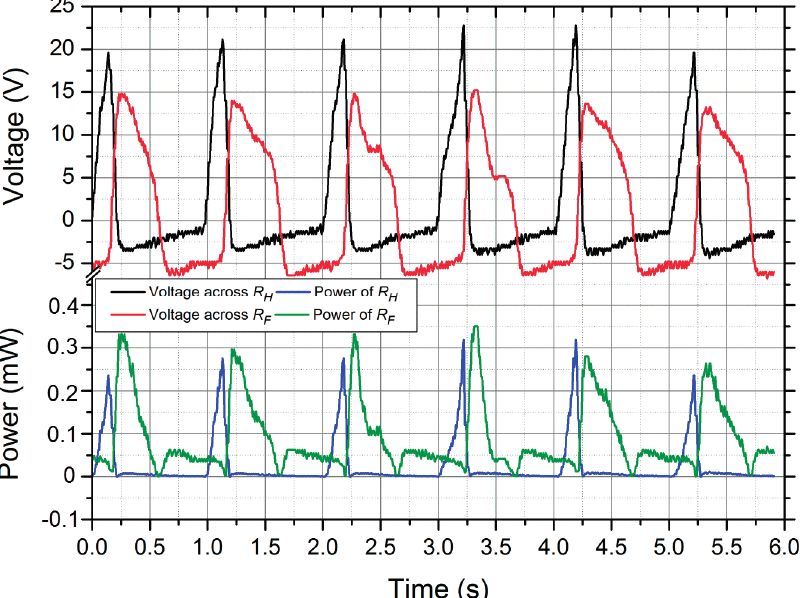
Figure 11. The voltages across R the